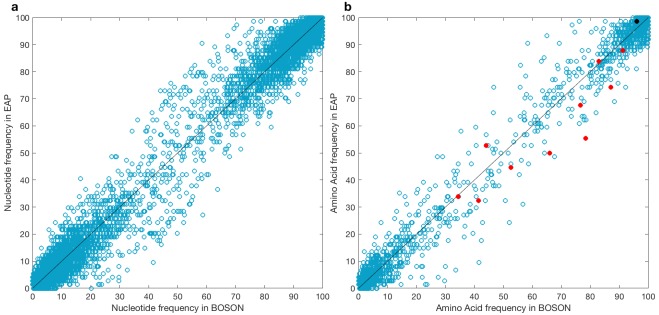
Viral allele frequencies in the BOSON (N = 411) and EAP (N = 74) cohorts.(a) Viral nucleotide and (b) amino acid frequencies in the BOSON and EAP cohorts. The red dots represent the 10 amino acids previously reported to be associated with IFNL4 genotype. The black dot represents position 2576, which was identified in our previous study as a site associated with IFNL4 genotype (Ansari et al., 2017) but was not tested in the present study.